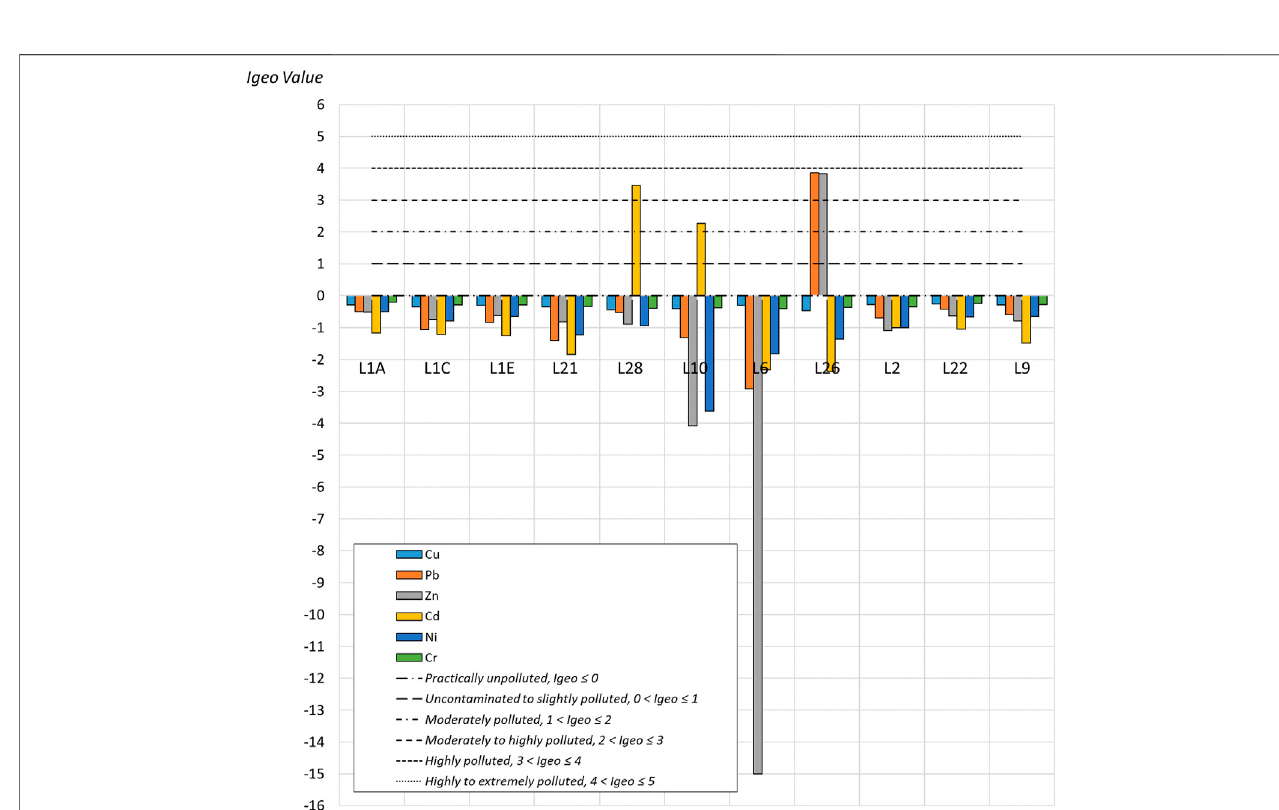
FIGURE 6 | I geo values for the studied soils in the vicinity of “ St. Kliment Ohridsky ” station.